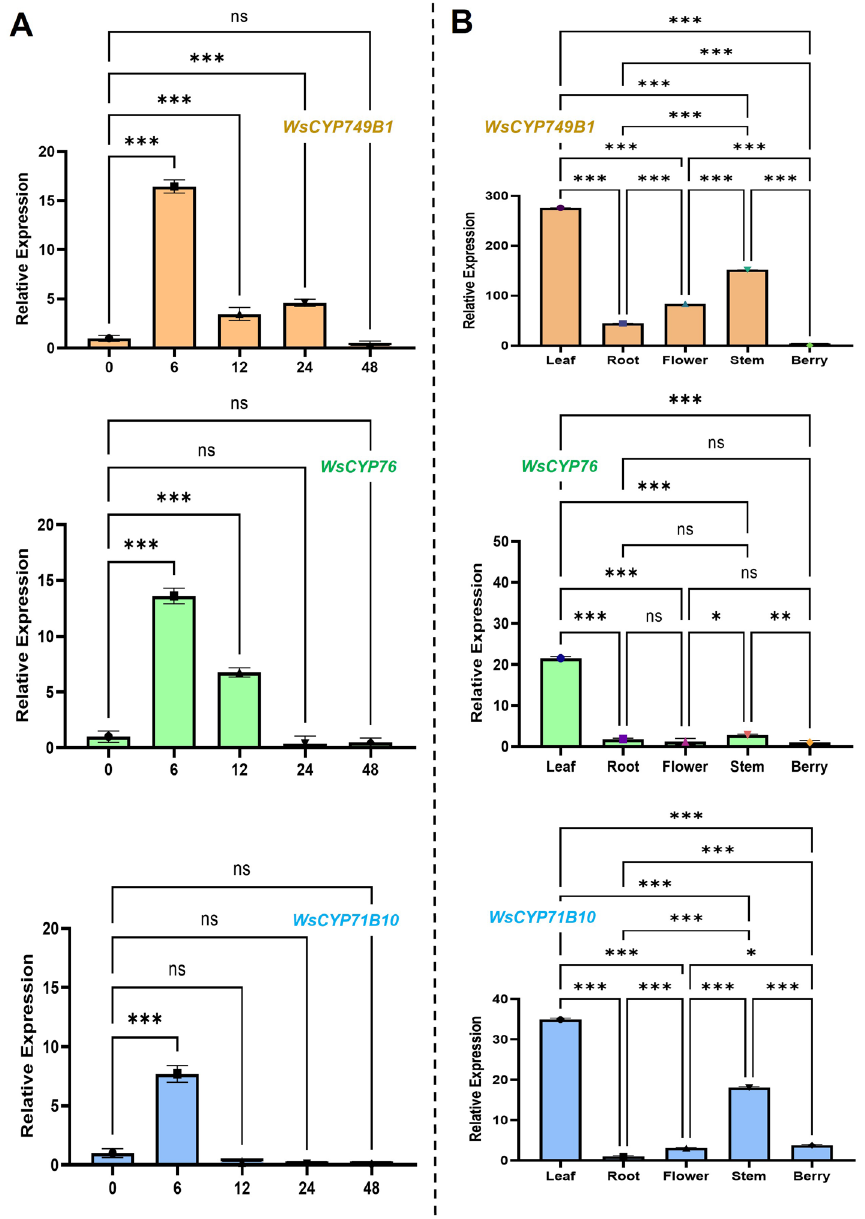
Figure 1. Analysis of transcript levels in response to MeJA and different tissues. ( A ) Effect of MeJA on the expression of WsCYP749B1, WsCYP76, and WsCYP71B10 at time intervals of 0, 6, 12, 24, and 48 h after treatment. The expression is represented relative to the buffer control. ( B ) Relative transcript abundance of WsCYP749B1, WsCYP76, and WsCYP71B10 in different tissues of W. somnifera . In each graph, the tissue having the least Ct was set to 1 to determine the relative abundance of transcripts in other tissues. 18s rRNA was used as an internal reference for normalization. Error bars show mean ± SE of three independent experiments. Statistical significance represented as * p < 0.033, ** p < 0.002, *** p <